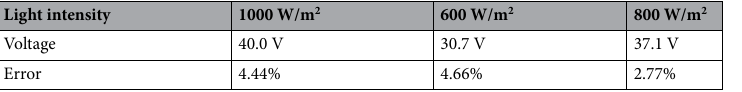
Table 3. Output voltage of two conductance increment methods under different light intensities.